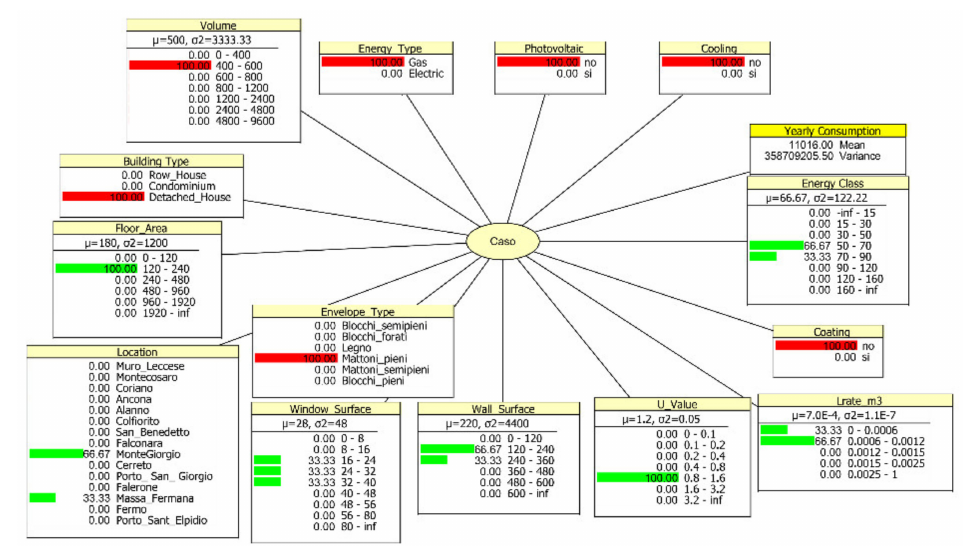
Figure 13. The index–frame used for condition assessment.